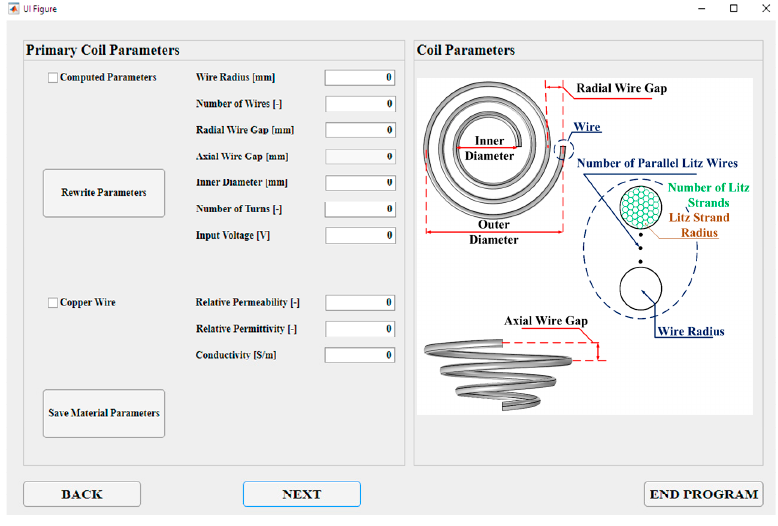
Figure 13. Display showing geometrical parameters definition (top—left part) and display showing material parameters definition (bottom—left part).